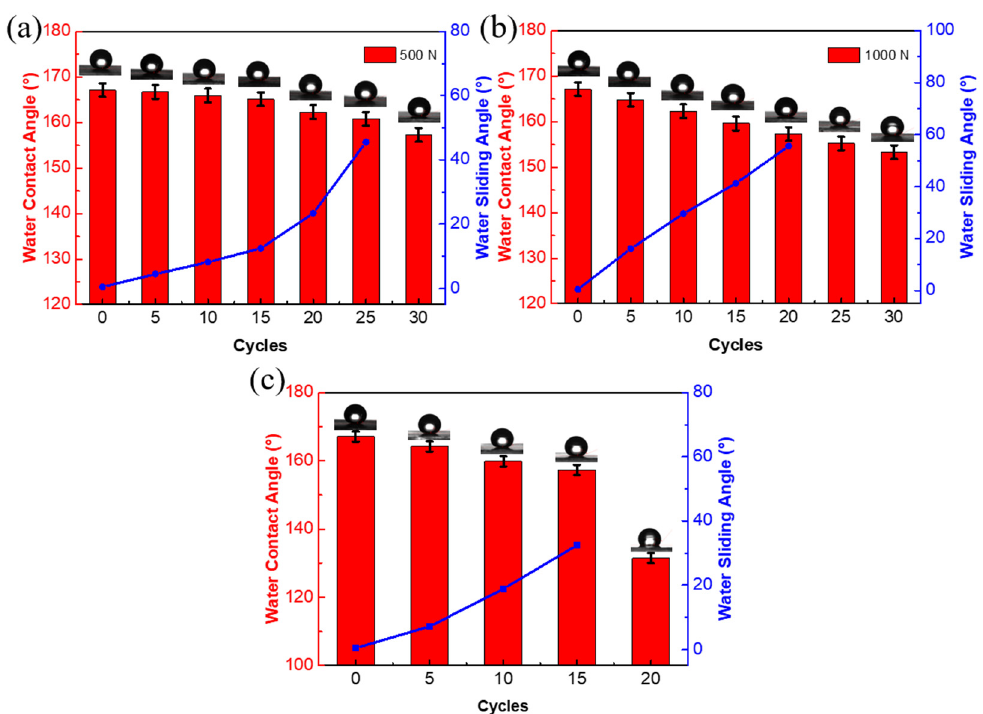
Figure 7. The changes of the WCA and WRA of the F 16 CuPc-modified film after the wear test with ( a ) 500, ( b ) 1000 N weight, and ( c ) tape stripping experiment.